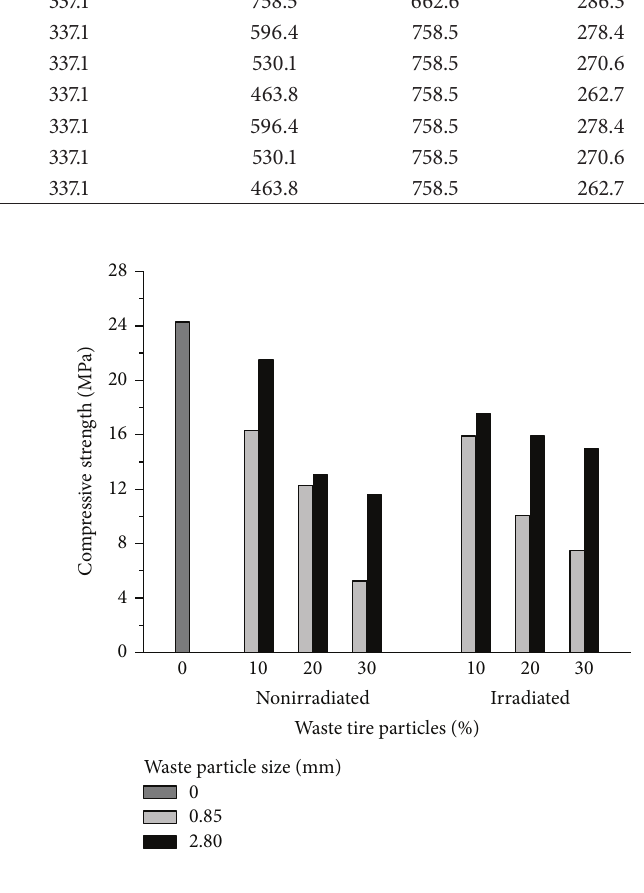
Figure 1: Unit weight of concrete with waste tire particles. Figure 2: Compressivestrengthof concrete with waste tireparticles.